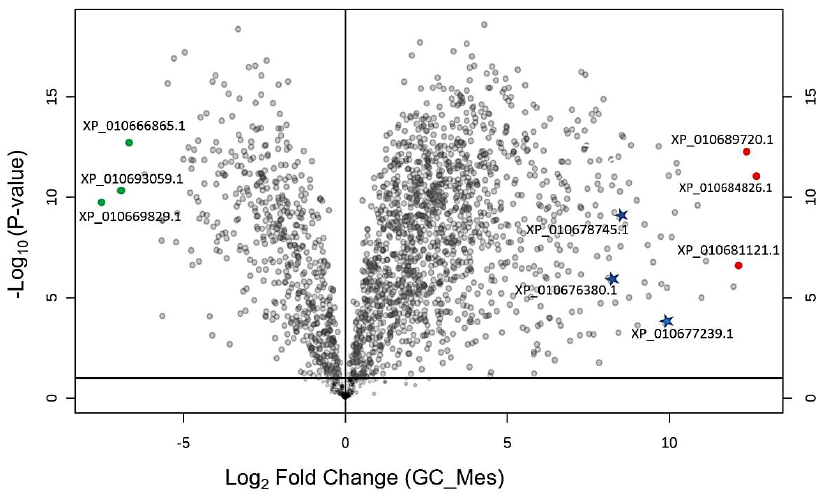
Figure 4. Comparison of differently abundant proteins in mesophyll and guard cells. Volcano plots displaying differentially abundant proteins in mesophyll and guard cell (FDR < 0.05). Three proteins with highest abundance and three proteins with lowest abundance in guard cells (GC) relative to mesophyll are marked in red and green, respectively. GC: guard cell; Mes: mesophyll, C: control conditions, S: saline conditions (300 mM NaCl).